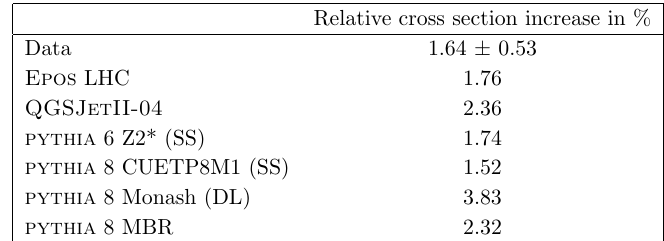
Table 3 . Relative increase in the cross section from the (cid:24) > 10 (cid:0) 6 to the (cid:24) X > 10 (cid:0) 7 or (cid:24) Y > 10 (cid:0) 6 (cid:12)ducial region. The uncertainty in the cross section ratio in data is obtained using systematic uncertainties only, varying each uncertainty source simultaneously for both phase space regions and obtaining the total uncertainty from the variation of the ratio, thus assuming full correlation between both measurements.